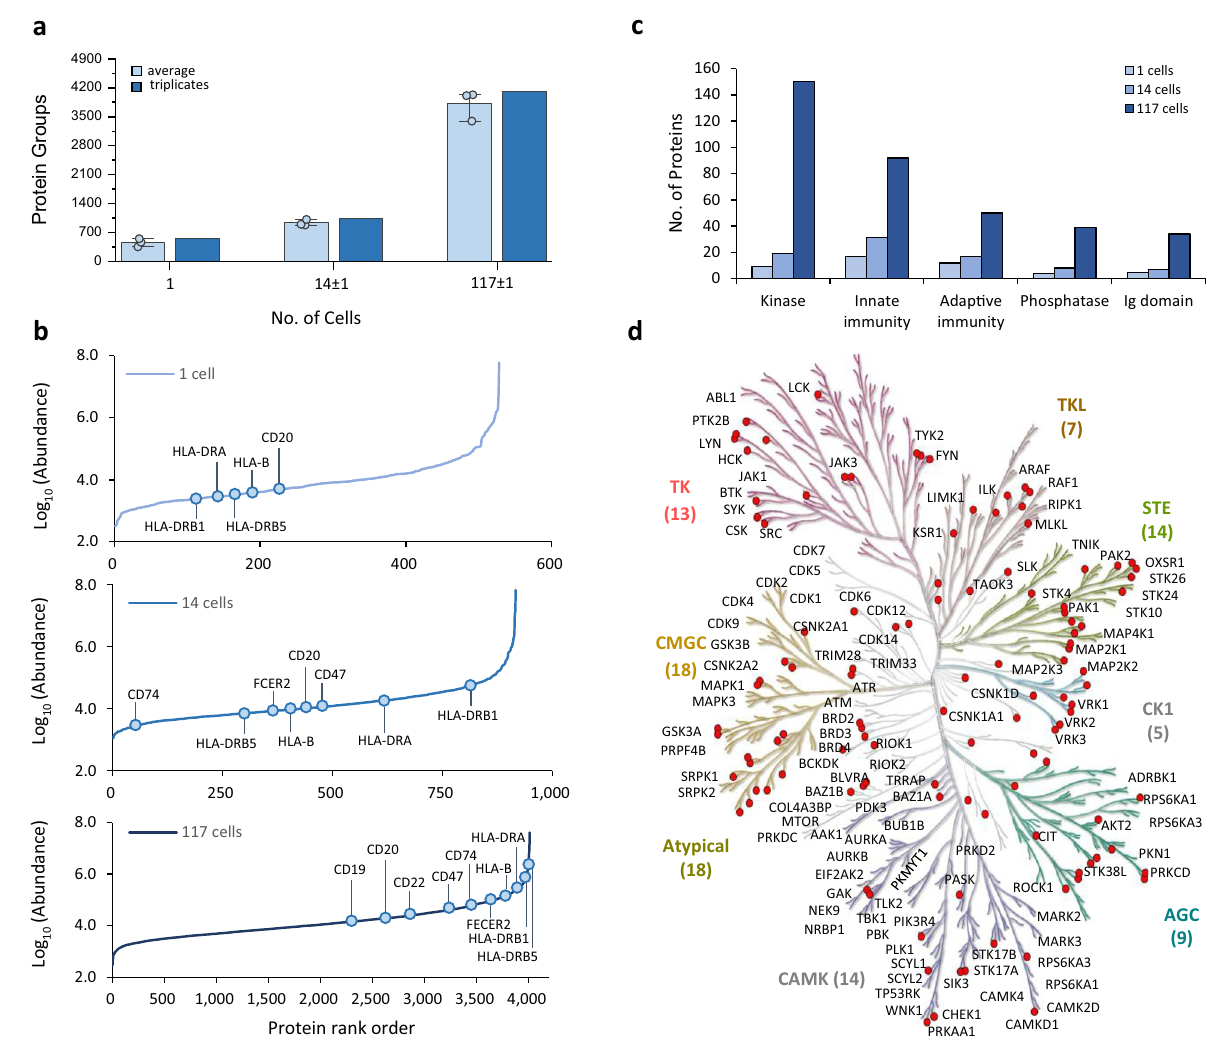
Fig. 5 Application of iProChip-DIA for proteomic pro fi ling of MEC-1 cells. a Identi fi cation summary of protein groups across different MEC-1 cell numbers by iProChip coupled to DIA-MS. Data are presented as mean values± SD ( n = 3 independent cell samples for each condition). b Assessment of dynamic range based on protein abundance rank and annotation of selected proteins related to immune cancer markers. c Enrichment of immune-related and other functional classes against the UniProtKB database. d Kinase tree for mapping 114 kinases from the total cell numbers. The kinase families listed includes TK (tyrosine kinases), TKL (tyrosine kinase-like), CK1 (casein kinase 1), CAMK (calcium/calmodulin-dependent protein kinase), AGC (containing PKA, PKG, PKC families), CMGC (containing CDKs, MAPK, GSK, CLK families), and STE (serine/threonine kinases many involved in MAPK kinases cascade). Source data are provided as a Source data fi